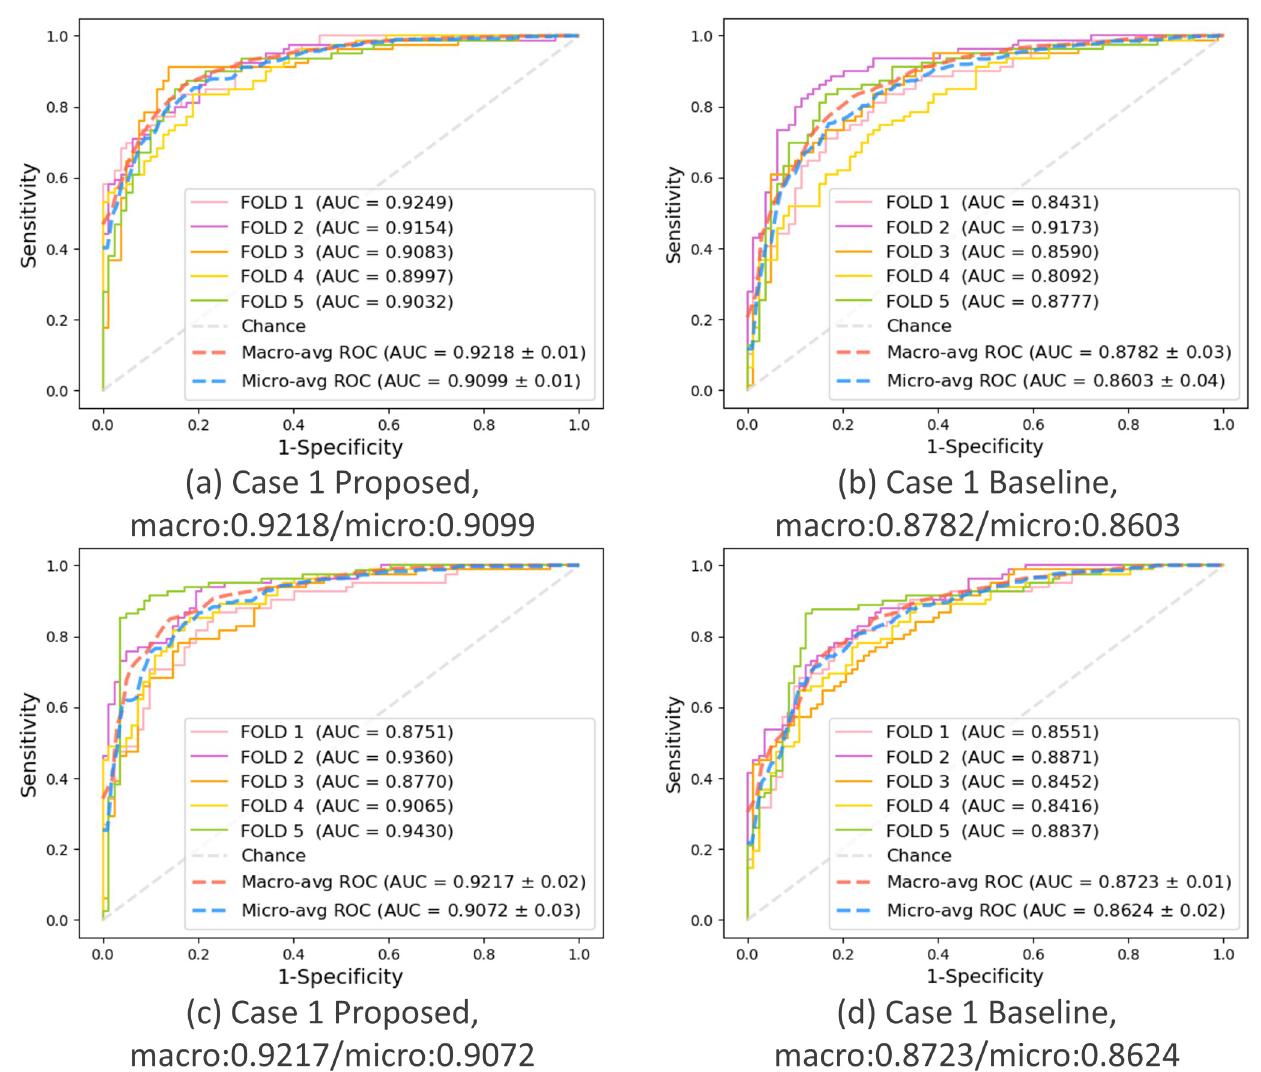
Fig 5. Case 1: Hypokinetic dysarthria vs. others. Comparison of the performance between the proposed and baseline schemes in terms of AUC. (a) Autumn + proposed, (b) Autumn + baseline, (c) Number + proposed, (d) Number + baseline.